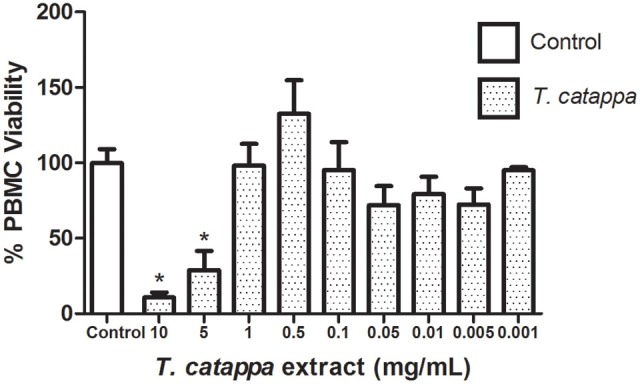
PBMC cell viability after exposure to different concentrations of TcHE. Symbol (*) represents statistical differences between the control and experimental groups (ANOVA one way followed by Dunnet test, p < 0.05).